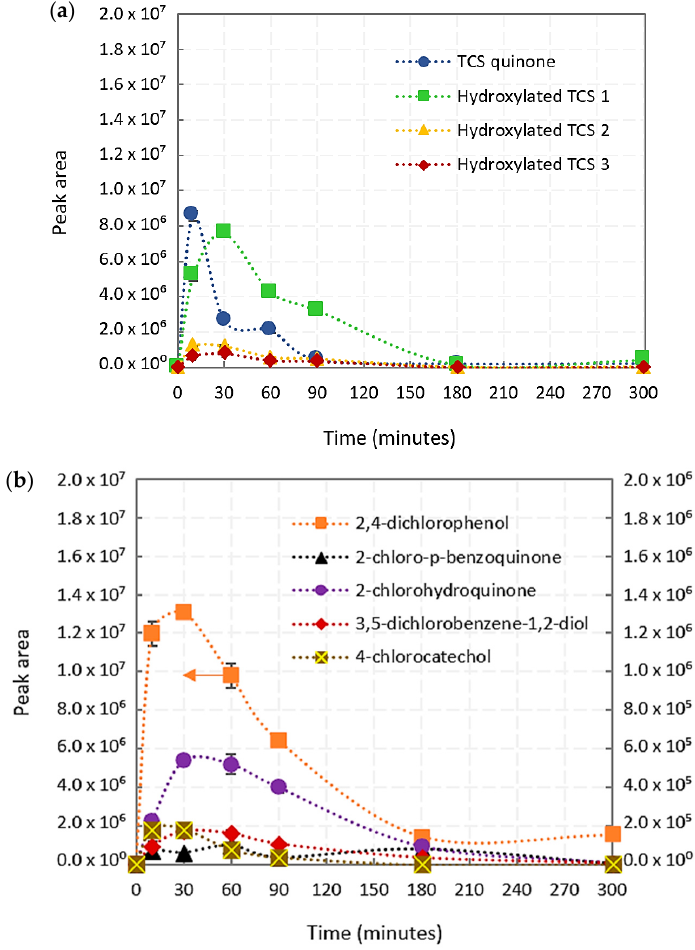
Figure 4. Time courses of ( a ) HICs and ( b ) LOCs derivatives formed during TCS photocatalysis. Lines have been added for a better readability of the data.